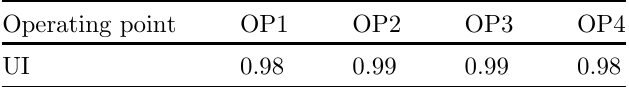
Table 5. Velocity uniformity index with